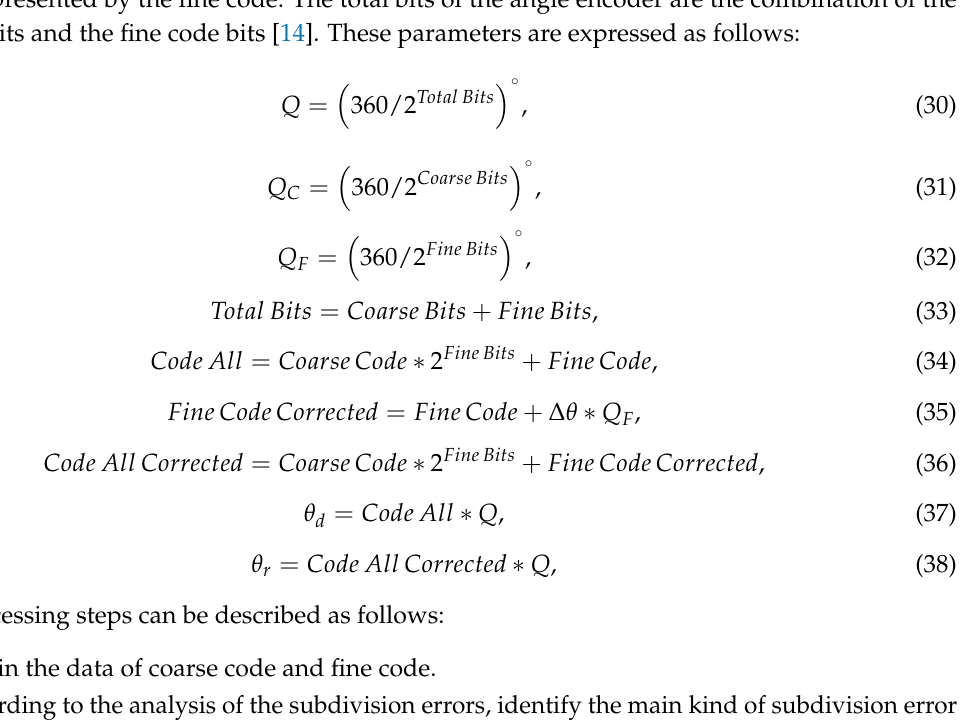
Figure 8. Working process of the angle encoder (including subdivision errors).